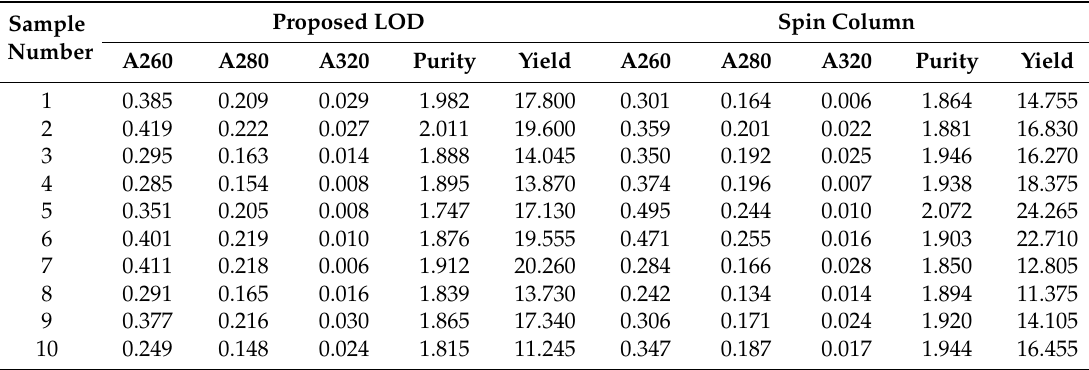
Table 2. Absorbance comparison of the proposed LOD and existing spin column.